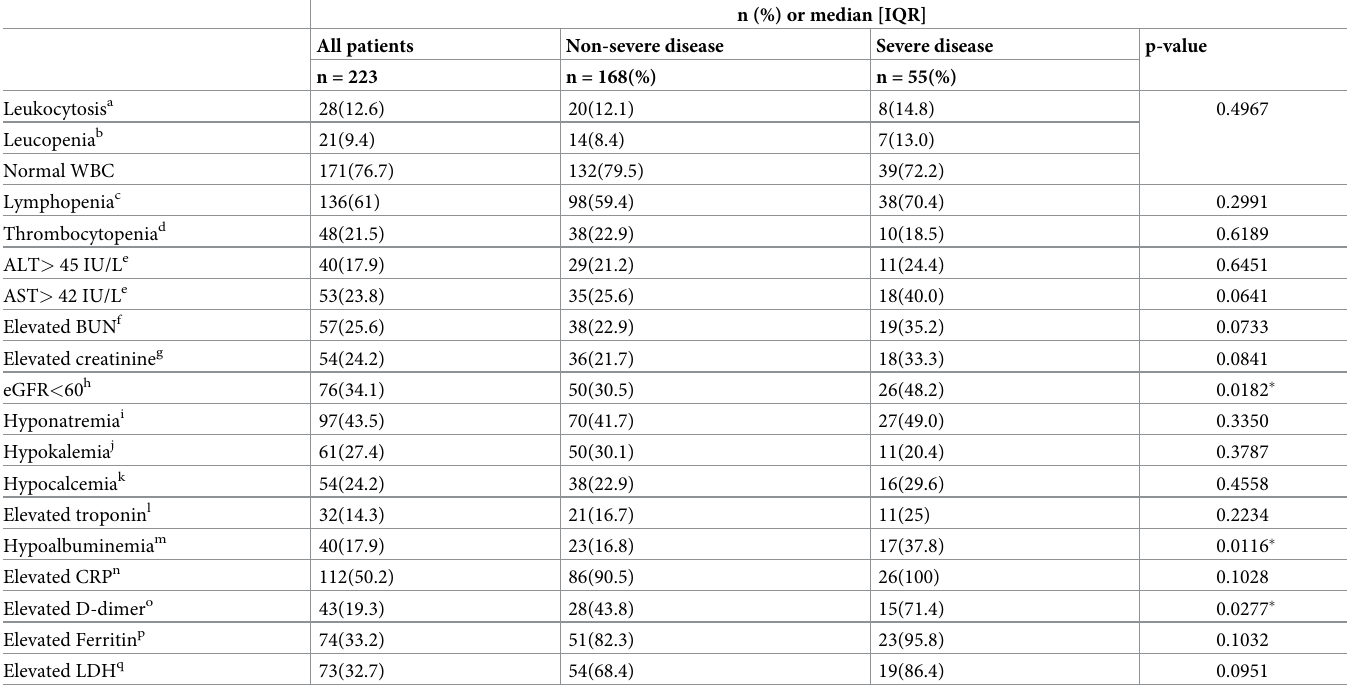
Table 6. Laboratory values during the first 24 hours of